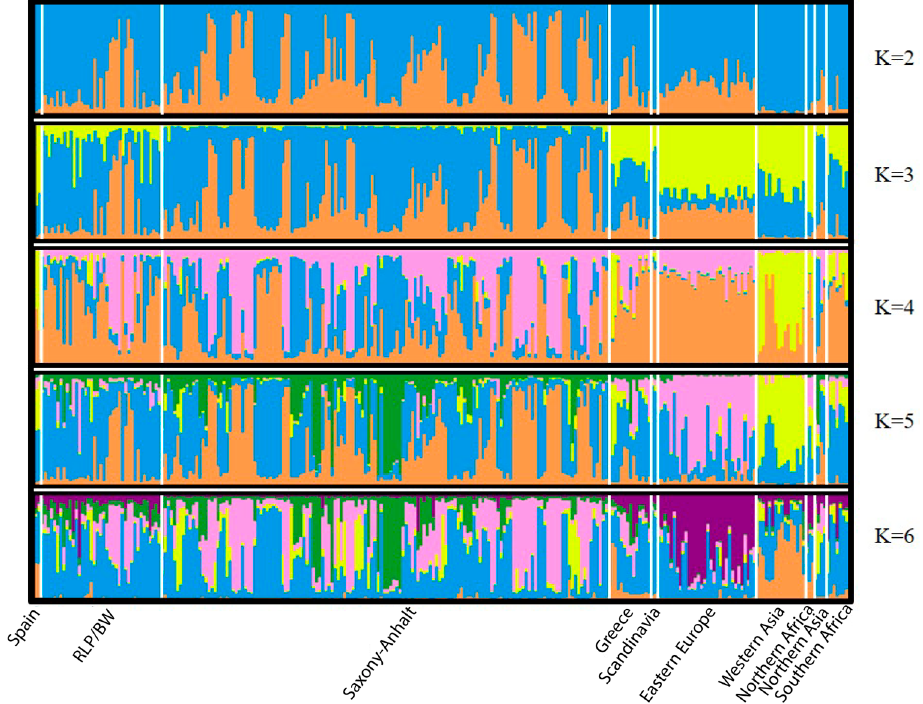
Figure 4. Graphic representation of Bayesian cluster analysis conducted in a structure based on six microsatellite loci performed with a K from 2 to 6. Population names are provided under the graphics. Each individual is represented by one vertical line and the colors point toward the probability of belonging to each of the genetic clusters.